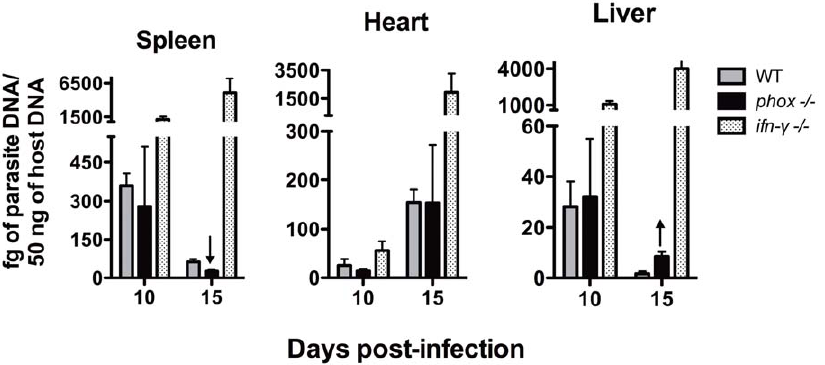
Figure 2. phox KO mice control parasite proliferation in target organs. WT, phox KO and inf- c KO mice infected with T. cruzi were sacrificed on days 10 and 15 post-infection and tissue parasitism in spleen, heart and liver evaluated by real-time PCR as described in material and methods. Bars represent mean 6 SE of four animals per group. Arrows indicate P , 0.05 between WT and phox KO animals. The parasitism of ifn- c KO group is statistically different from WT and phox groups in all organs and times analyzed, except for the heart at day 10